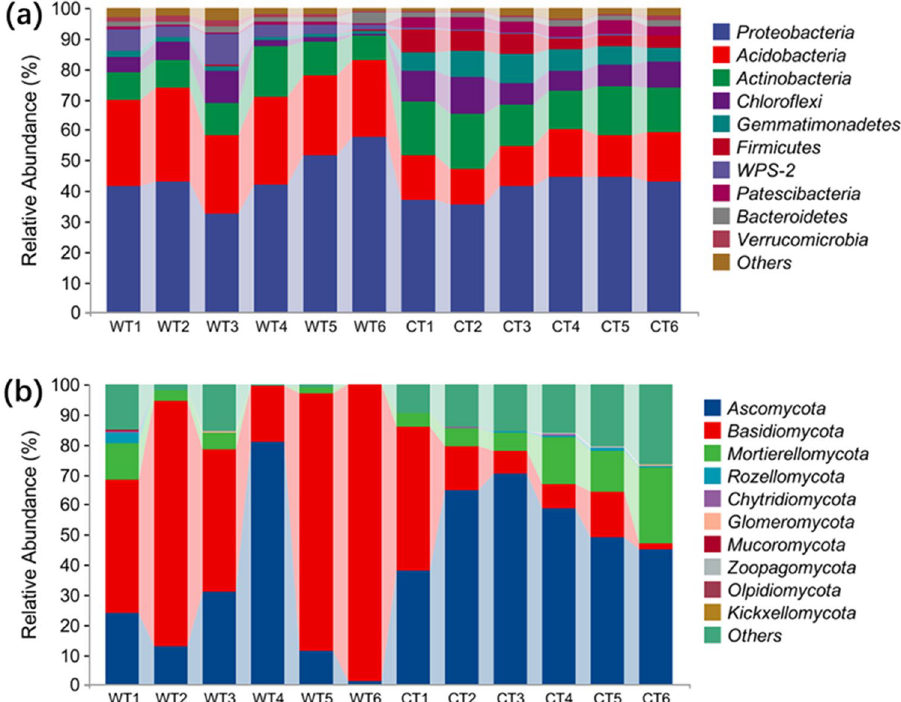
Figure 2. Relative abundance of soil bacterial phyla ( a ) and fungi phyla ( b ) from rhizosphere soil sampled under cultivated (CT) and wild conditions